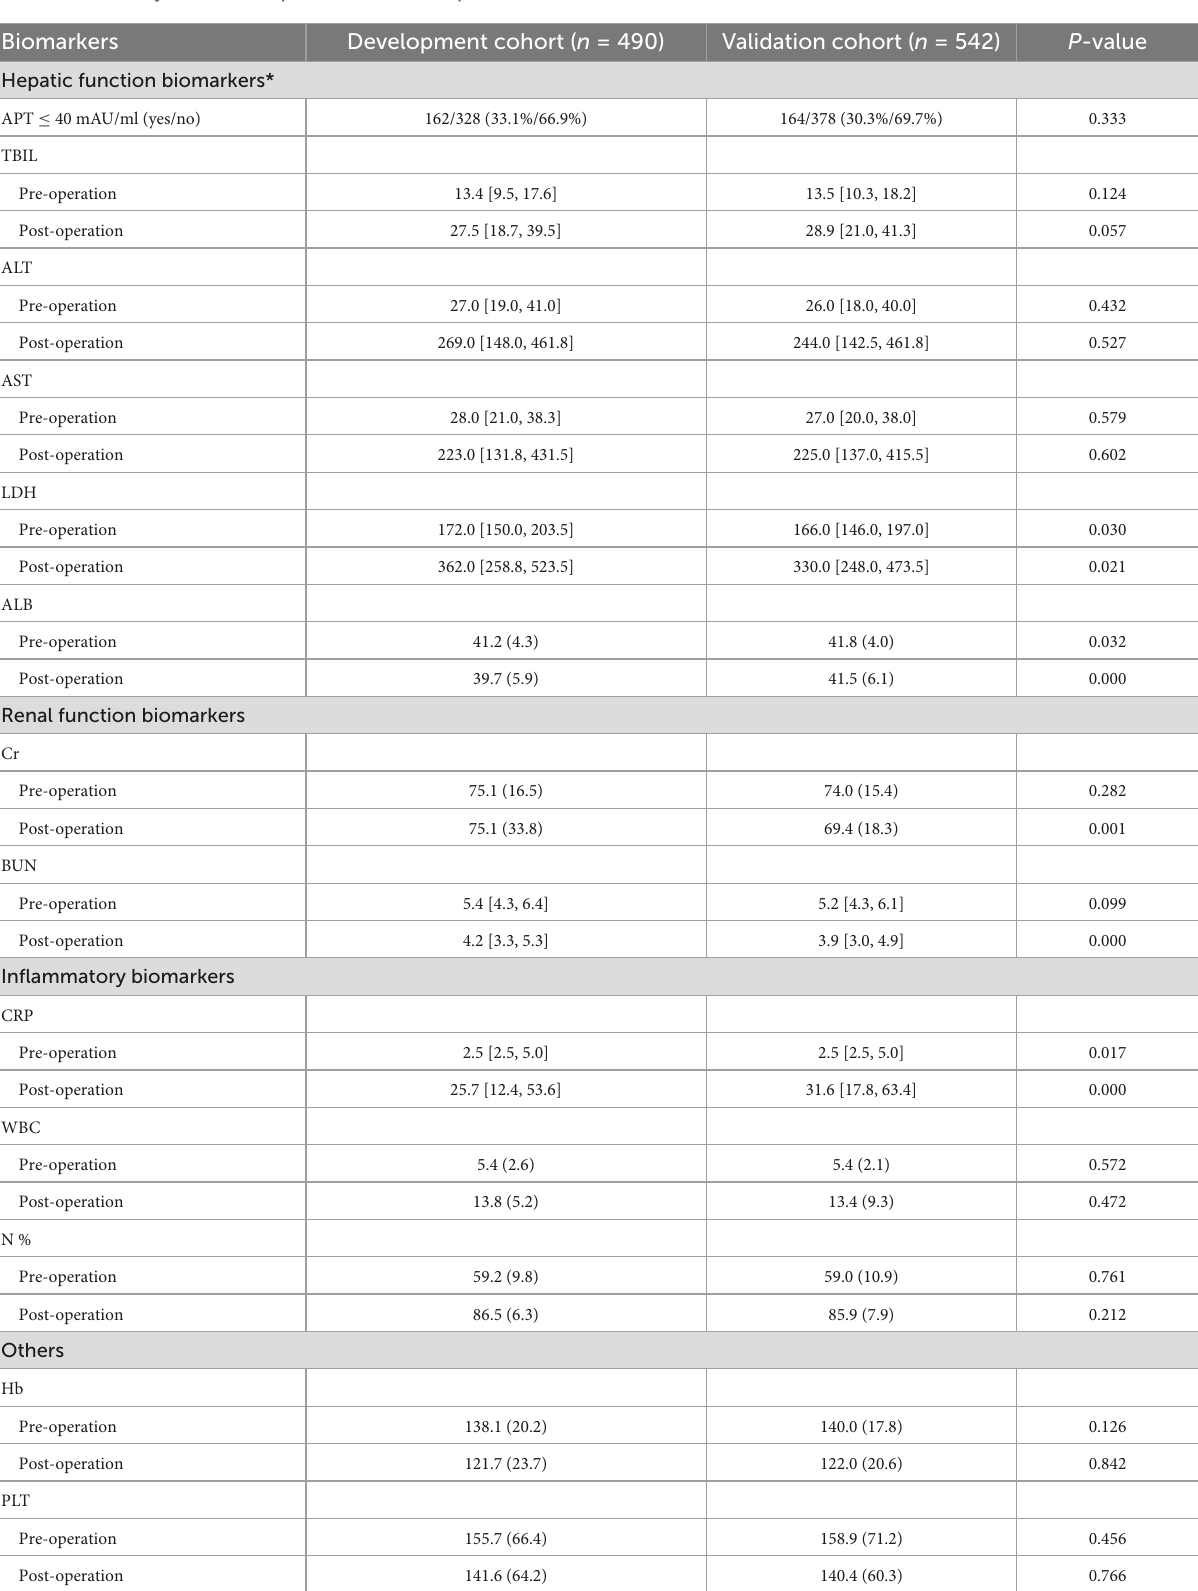
TABLE 2 Laboratory detections of patients in the development cohort and validation cohort.